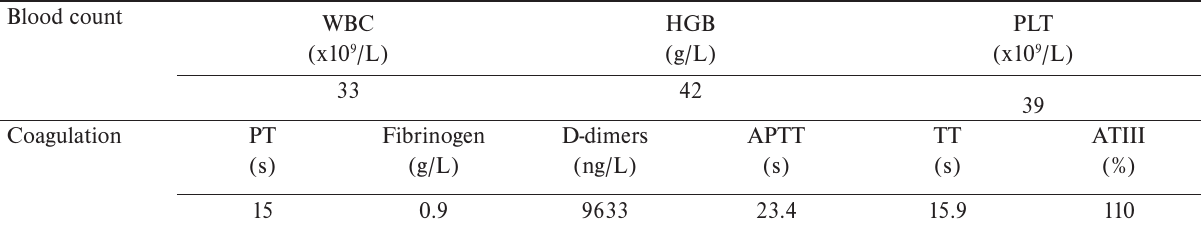
Table 2. Blood count and coagulation parameters before preoperative